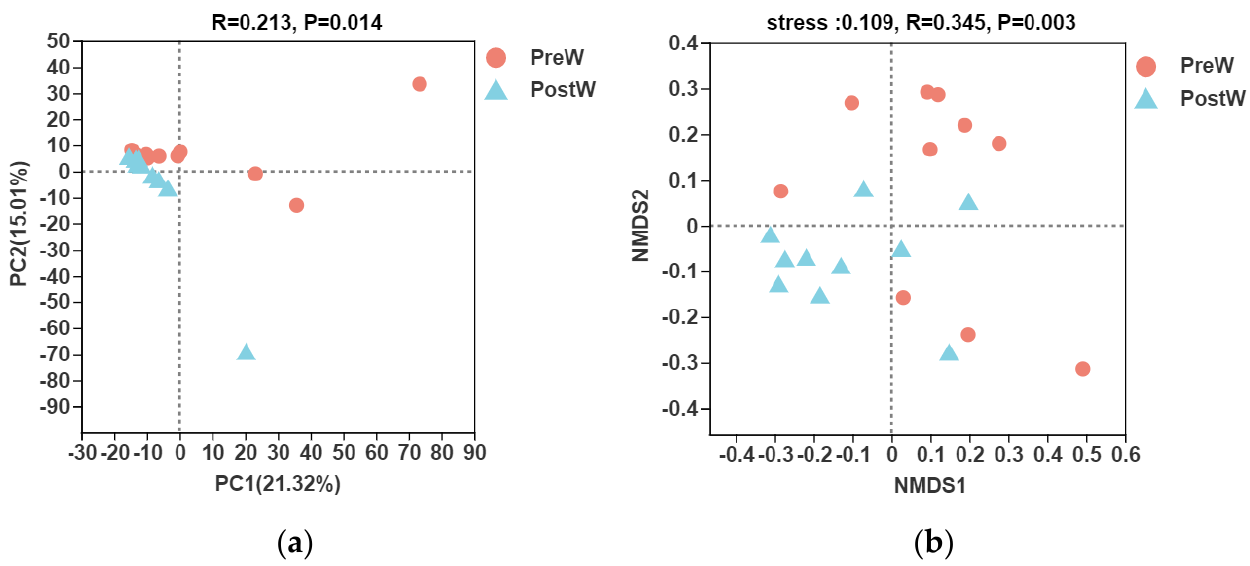
Figure 8. Principal component analysis (PCA, ( a )) and nonmetric multidimensional scaling analysis (NMDS, ( b )) of the oral bacteria community composition of the preweaning and postweaning donkeys at the OTU level. The Log10 transformed data were used for analysis, and the percentage values given on each axis represent the amount of total variation. PC1 or MNDS1, first axis; PC2 or MNDS2, second axis. PreW, preweaning group; PostW, postweaning group.